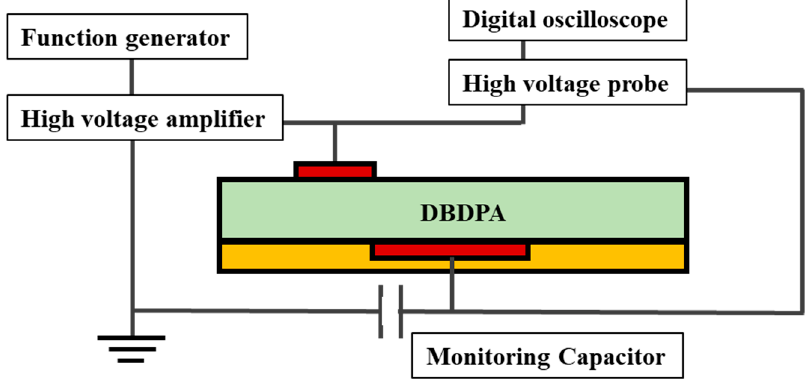
Figure 3. Schematic showing the experimental settings of the DBDPA.